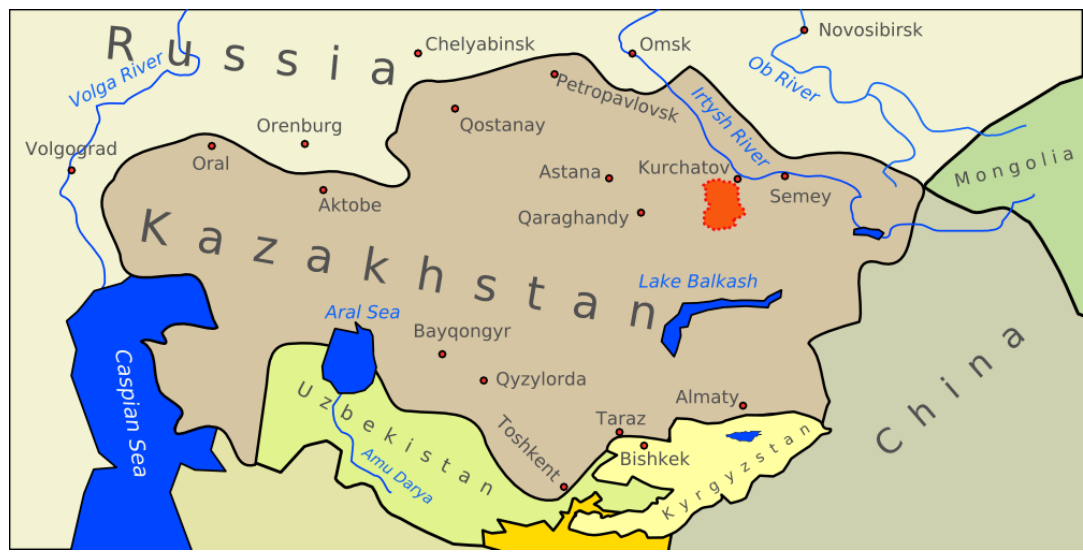
Figure 1: The 18,000 km 2 area of the Semipalantinsk Test Site (indicated in red attached to Kurchatov (along the Irtysh river), and near Semey, as well as Karaganda and